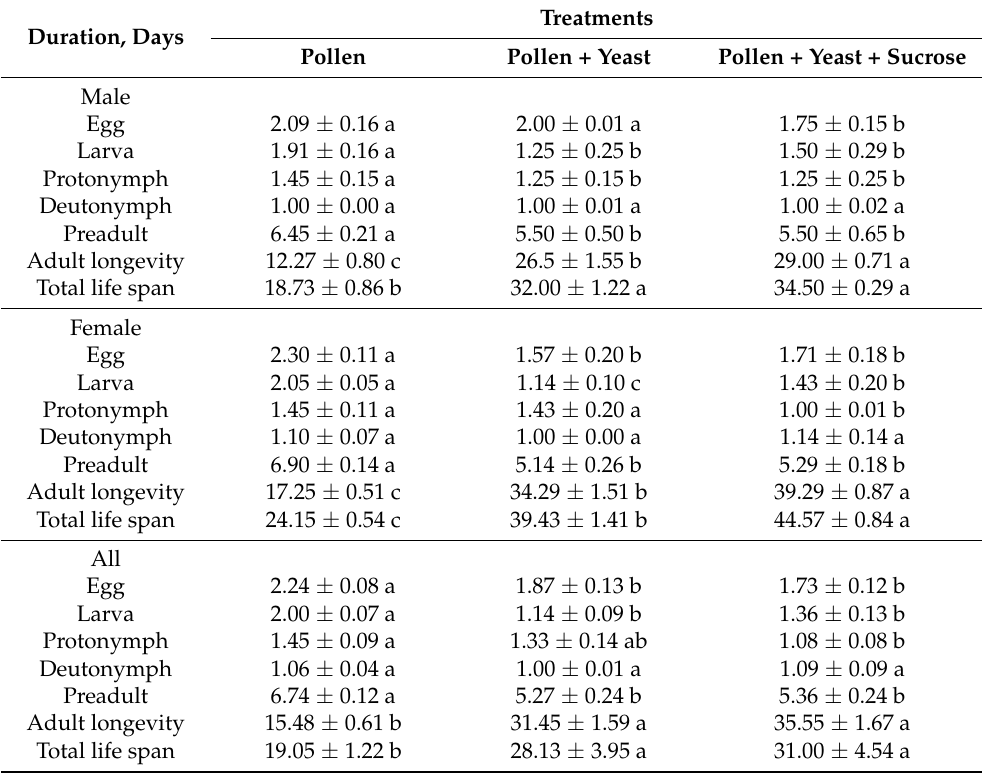
Table 1. The length of each developmental stage of individuals with Amblyseius orientalis in the different treatment groups.